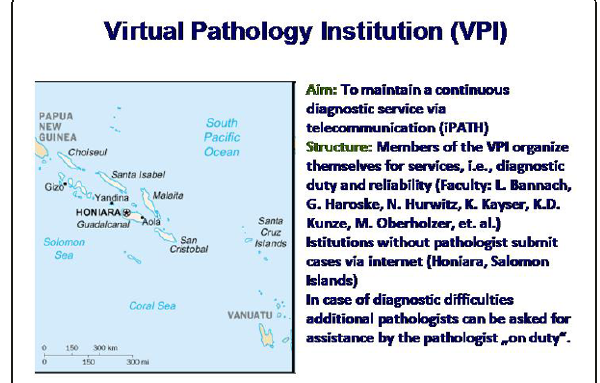
Figure 6 Data of the former VPI Salomon Islands